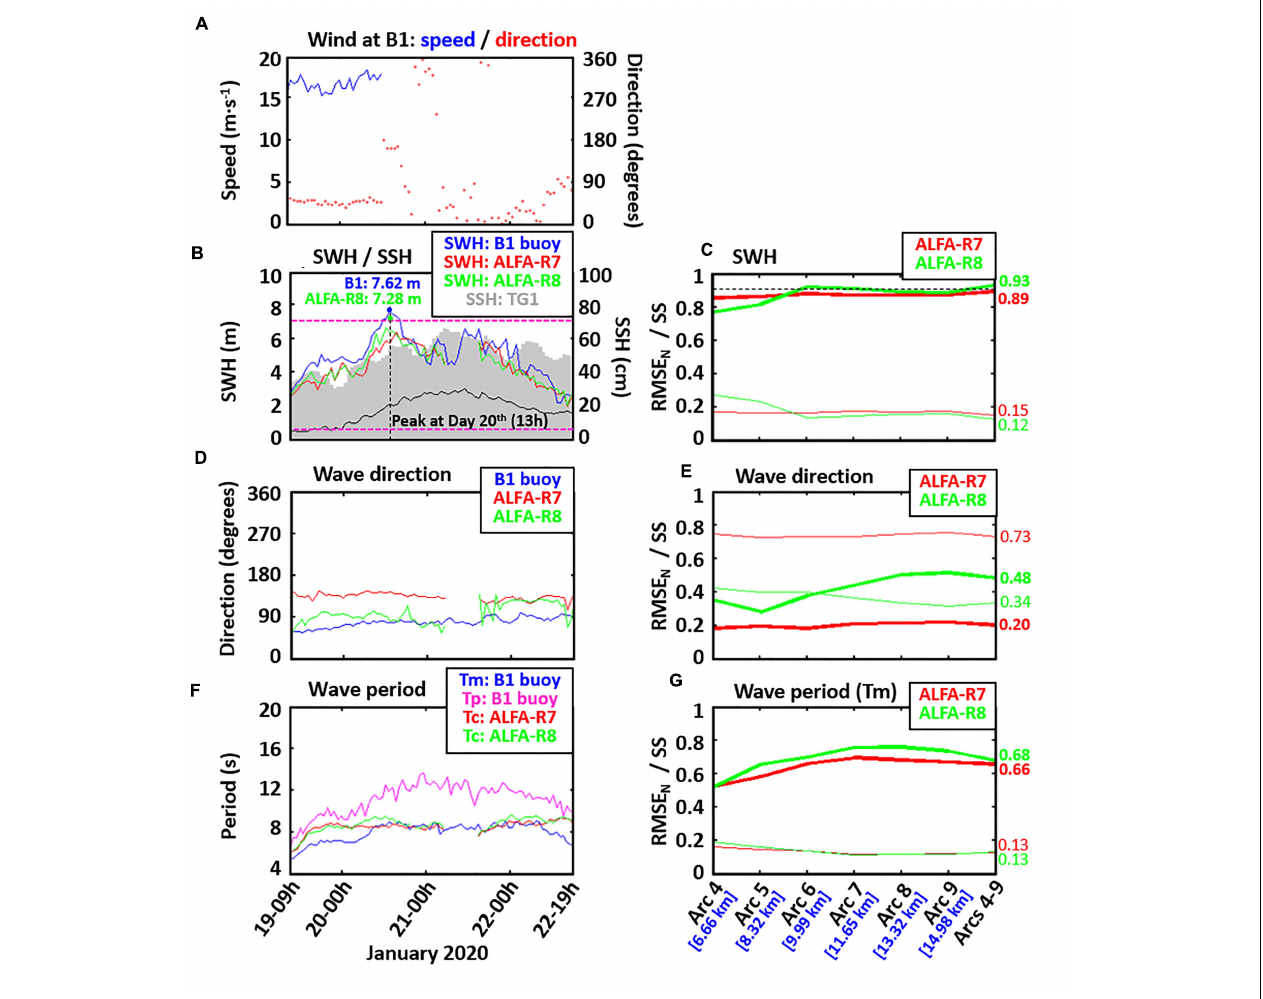
FIGURE 3 | (A) Wind speed (blue line) and direction (red dots) measured at B1 buoy during the storm Gloria (3.5-day period); there was an outage in wind speed data collection after the storm peak; (B–G) Comparison of HFR-derived wave parameters (provided by ALFA site: Arcs 4–9) against hourly in situ observations from B1 buoy. Gray columns and the black line represent the hourly sea surface height (SSH) and meteorological tide recorded at TG1 tide-gauge, respectively. On the right, skill scores (SS, bold lines) and RMSE N (thin lines), obtained for each parameter at each selected HFR range arc. Arcs 4–9 represents an average of wave estimations from all those range arcs. Red and green lines indicate the skill metrics derived from HFR wave estimations obtained by using R7 and R8 CODAR software packages, respectively. Pink dashed lines in panel (B) represent the lower and upper thresholds for the significant wave height (SWH) data collection, according to the frequency (13.5MHz) at which the HFR-ED